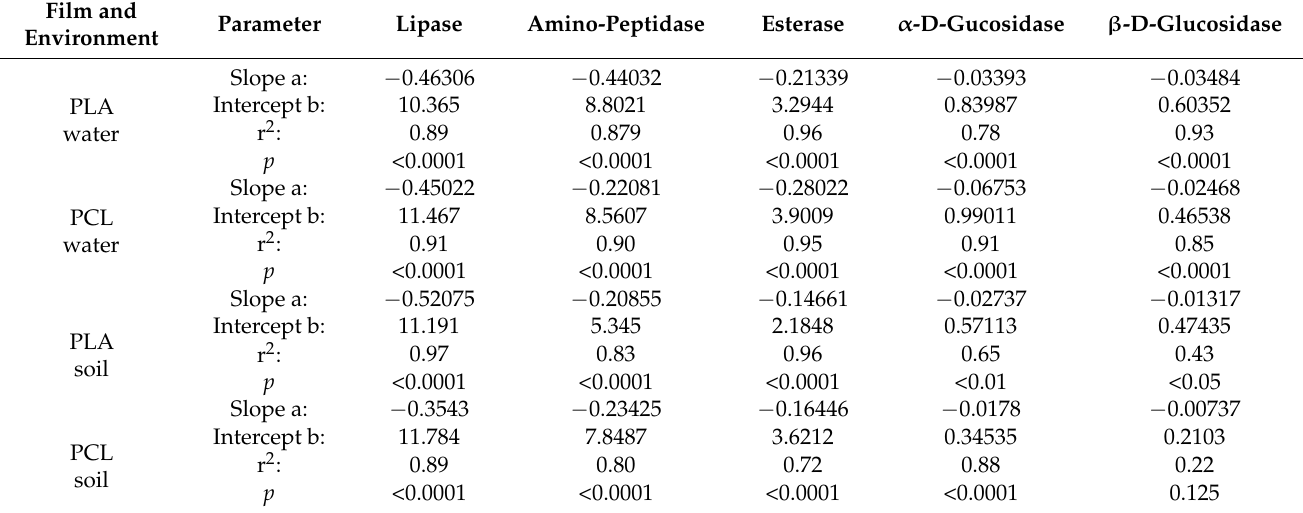
Table 2. Mann-Whitney test for equal medians for enzyme activities in different materials and en- vironments.